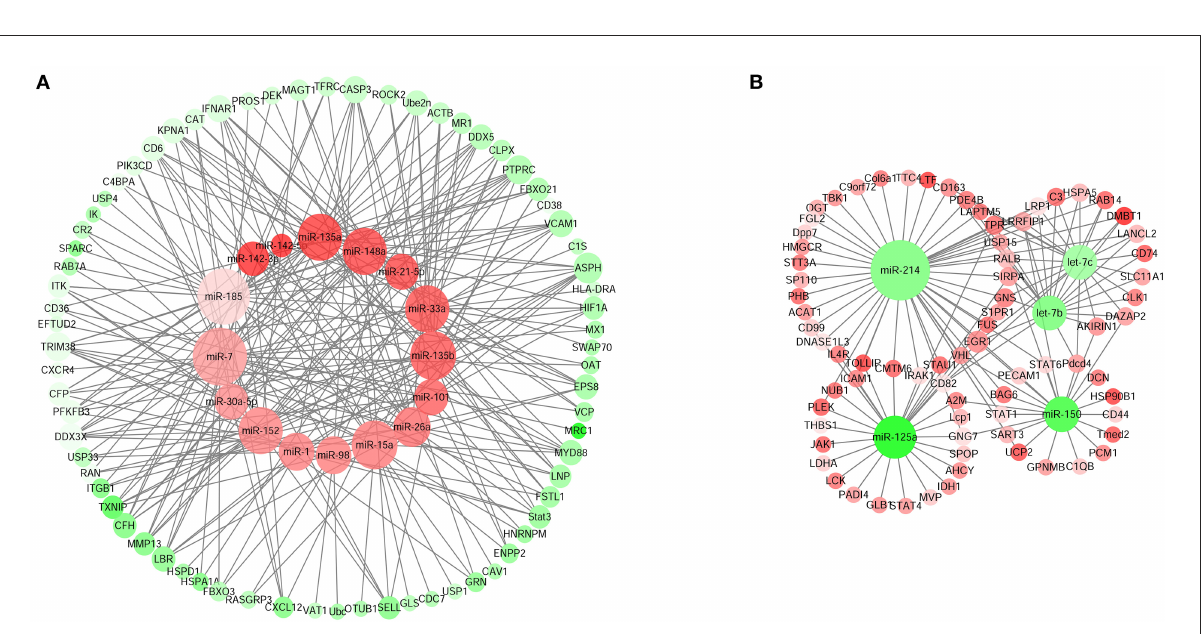
FIGURE7 MiRNA–mRNA interaction networks related to immune response in spleen. (A) Up-regulated miRNAs and down-regulated target genes related to immune response in spleen. (B) Down-regulated miRNAs and up-regulated target genes related to immune response in spleen. The up-regulated miRNAs or genes were displayed as red circles, and the down-regulated miRNAs or genes were displayed as green